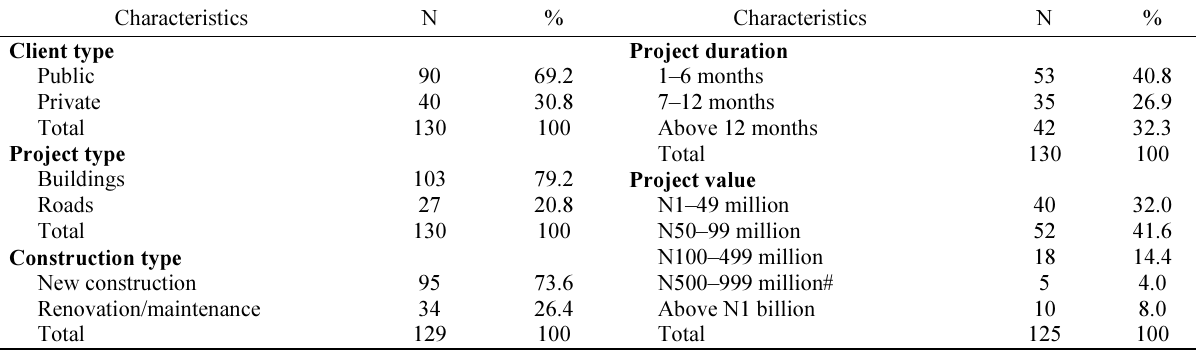
Table 2. Descriptive results of the characteristics of projects used for the study Characteristics